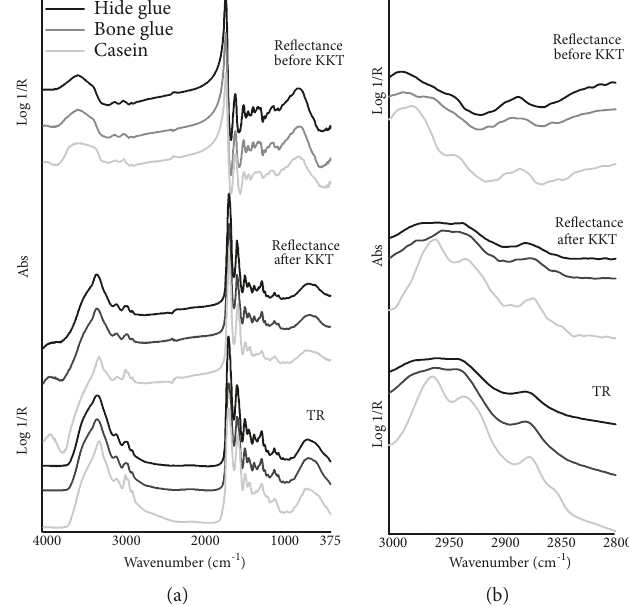
Figure 1: FTIR spectra in the mid-infrared region of the studied proteinaceous materials (black line: hide glue, gray line: bone glue, light gray line: casein) using different analysis modes. From top to bottom: total reflection mode before the KKT correction, total reflection mode after the KKT correction, and transflection mode. Spectral regions of (a) 4000-375cm −1 and (b) CH stretching